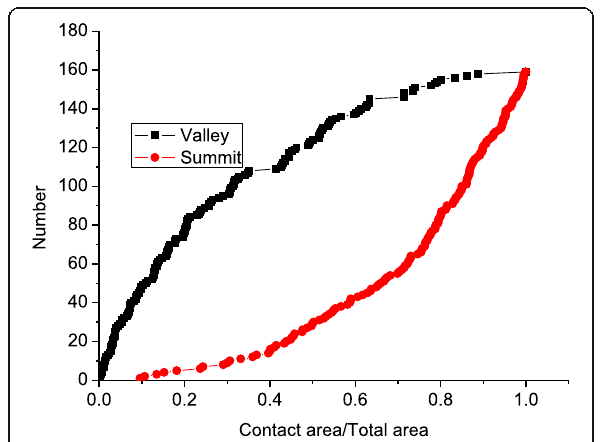
Fig. 8 The surface valley and summit numbers grow at different areas